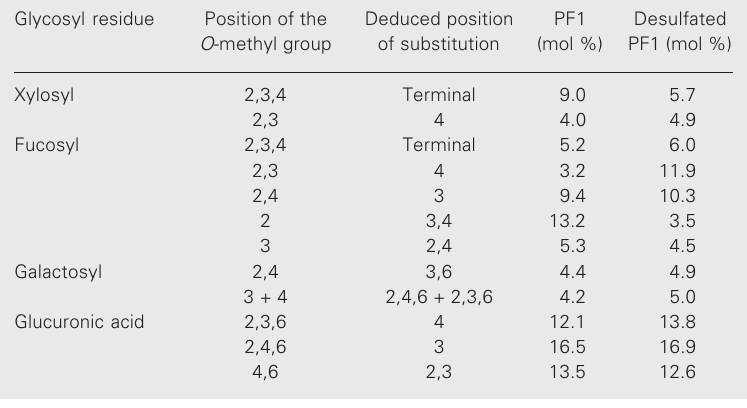
Table 3. Methylation analyses of native and desulfated PF1. Glycosyl residue Position of the